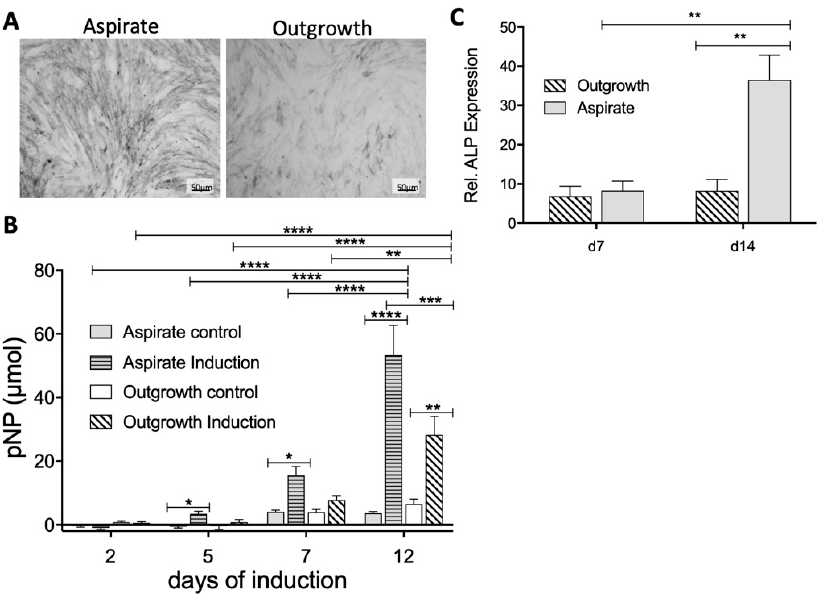
Figure 6. Comparison of alkaline phosphatase (ALP) expression by aspirate and outgrowth-derived MSCs. ( A ) ALP staining: The NBT / BCIP solution exhibited a black precipitate indicating the presence of ALP enzyme. MSCs from aspirate cultures showed a stronger ALP signal compared to outgrowth-derived MSCs. ( B ) Results of the ALP assay were evaluated by OD measurements. Starting at day 5, induced MSCs from aspirate showed higher ALP activity in comparison to the outgrowth-derived MSC group. ( C ) Relative gene expression level of ALP was determined using reverse transcriptase polymerase chain reaction (RT-PCR) for MSCs from both groups. * p < 0.05, ** p < 0.01, *** p < 0.001, **** p < 0.0001.